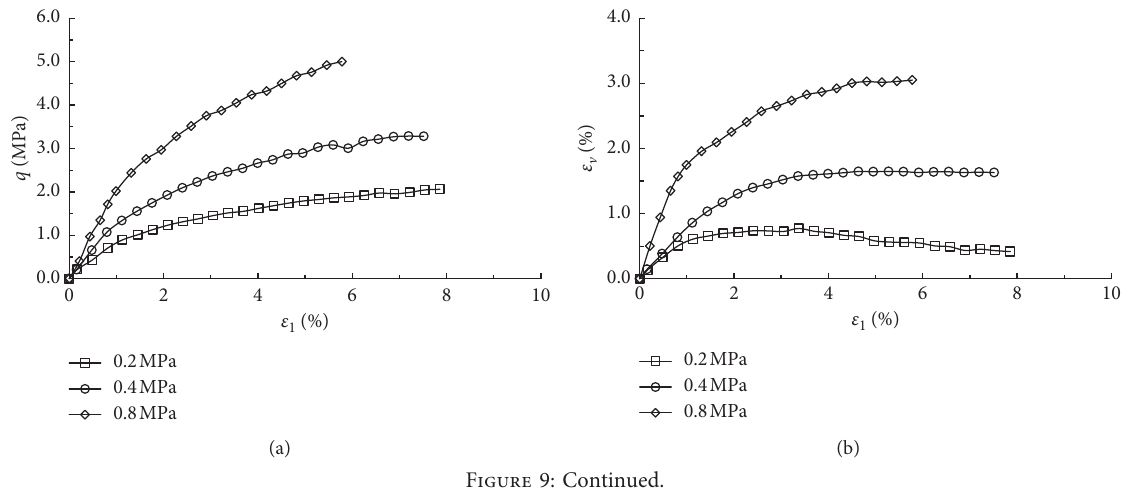
� 0.2MPa: (a) stress-strain curves; (b) volumetric strain curves; (c) stress